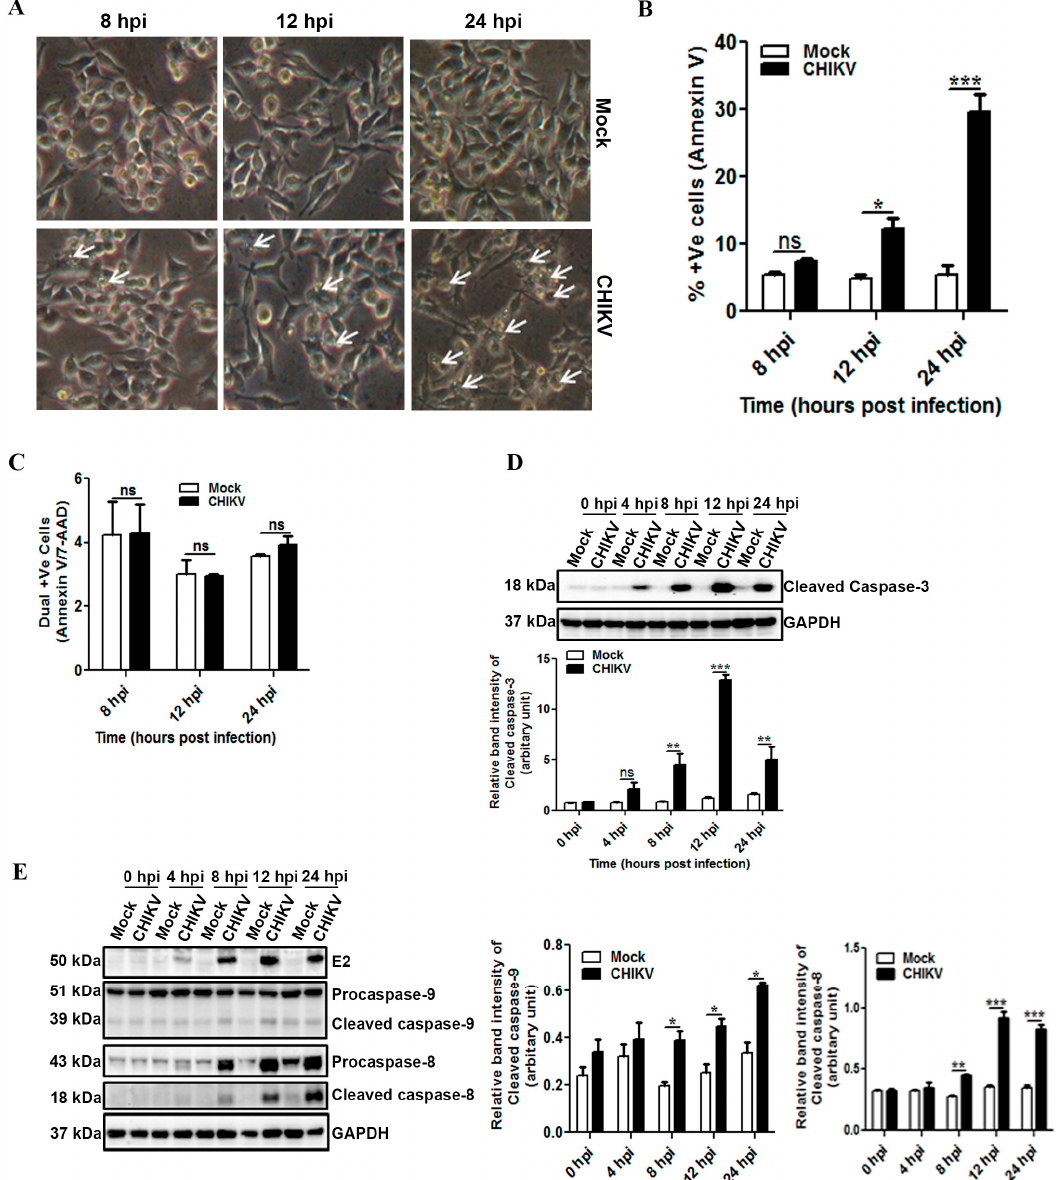
Figure 2. Induction of apoptosis following CHIKV infection in Macrophages. Raw264.7 cells were infected with CHIKV at MOI 5 for different time points as described earlier. Infected cells were viewed under bright field microscope or processed for FC analysis. ( A ) Bright field microscopic images taken at 8, 12 and 24 hpi with 20 × magnification. White arrows indicate observed morphological changes in the infected cells. ( B ) Graphical representation showing percent positive cells for Annexin V in mock (white bar) and CHIKV infected samples (dark bar) at 8, 12 and 24 hpi. ( C ) Bar diagram showing percent dual positive cells for Annexin V and 7-AAD in mock (white bar) and CHIKV infected samples (dark bar) at 8, 12 and 24 hpi. ( D ) CHIKV infected Raw cells were harvested, lysed and separated by SDS-PAGE. Western blot was performed and expression pattern of cleaved caspase-3 was assessed at different hpi as shown (upper), bar diagram showing relative band intensity of cleaved caspase-3 (lower). GAPDH was used as loading control. ( E ) Western blot analysis of E2, caspase-9 and caspase-8 (left), bar diagram showing relative band intensity of cleaved caspase-9 and cleaved caspase-8 (right). Data represent mean ± SEM of at least three independent experiments. p < 0.05 was considered as statistically significant difference between the groups. (* p < 0.05; ** p ≤ 0.01; *** p ≤ 0.001).